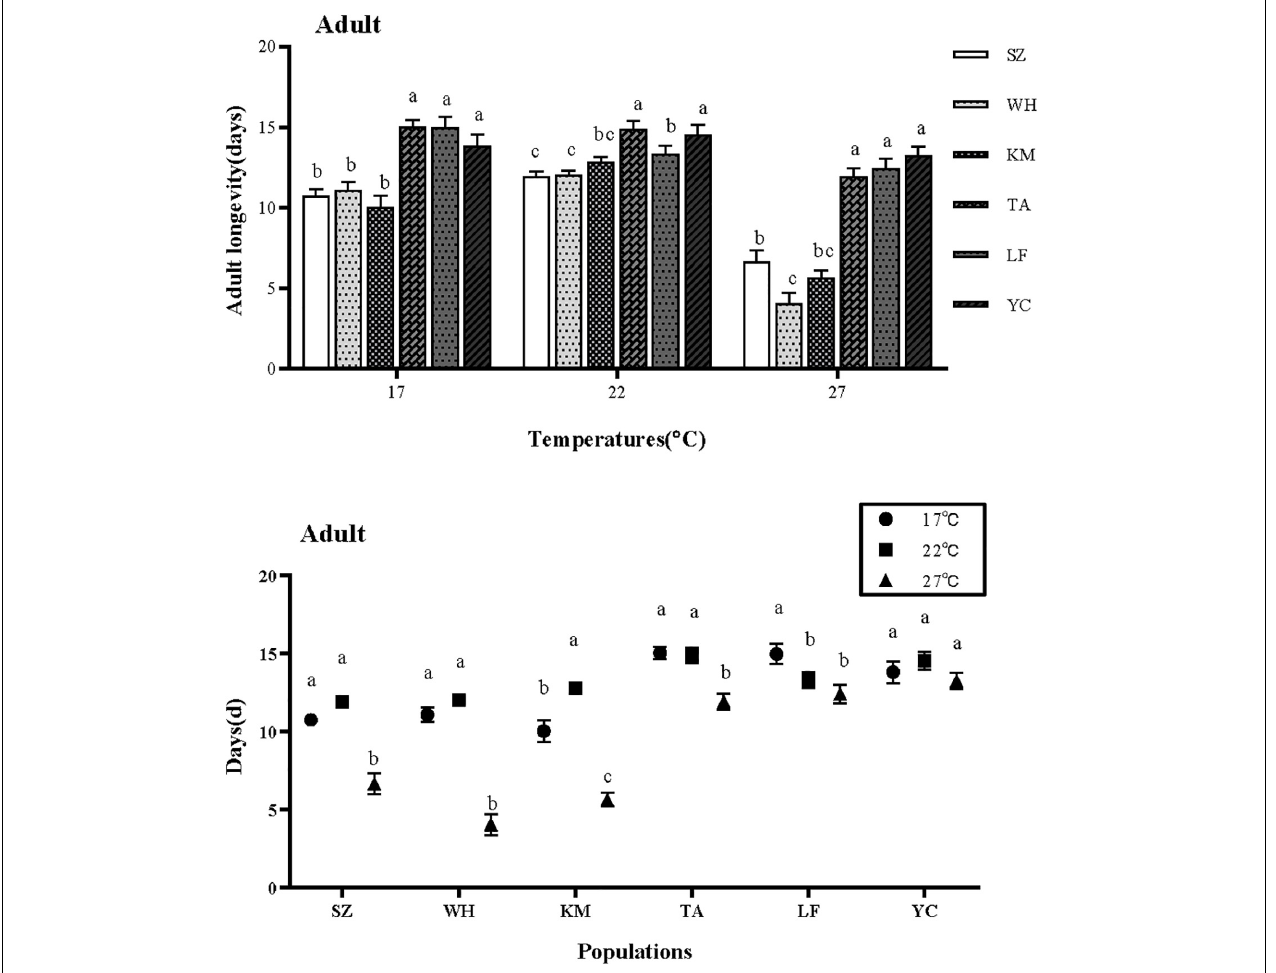
FIGURE 3 | Effect of different temperatures on adult longevity of S. miscanthi. SZ, Suzhou; WH, Wuhan; KM, Kunming; TA, Tai’an; LF, Langfang; YC,